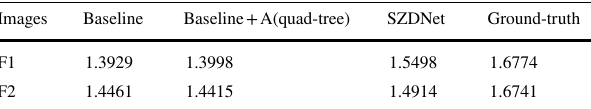
Table 4 Results on the SOTS dataset Method